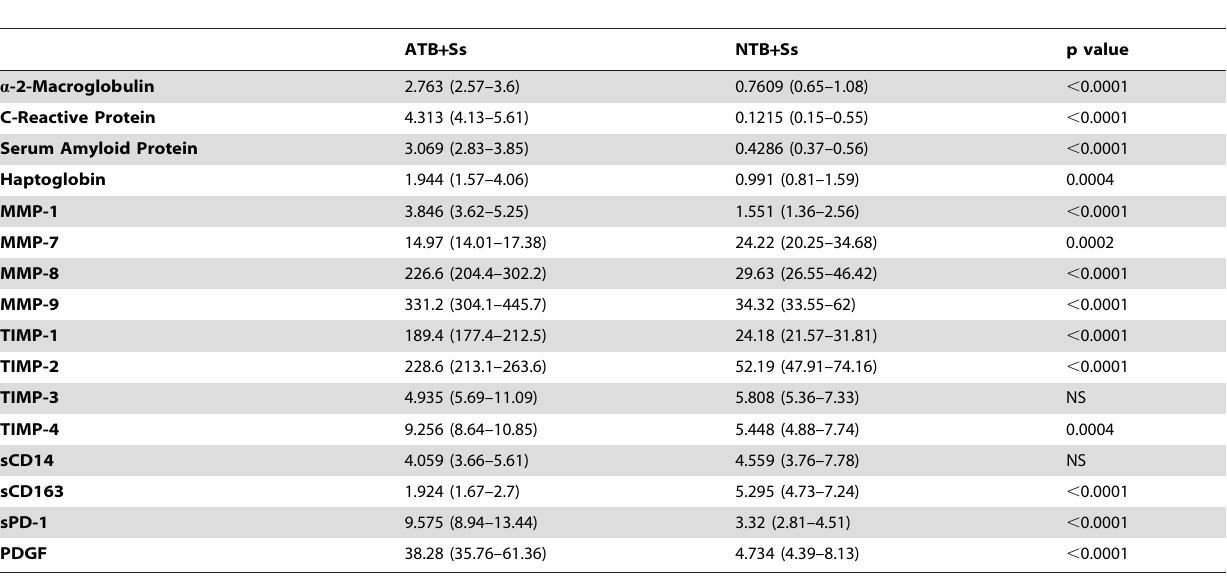
Table 3. Systemic levels of immune parameters in active TB and TB uninfected individuals with concomitant Strongyloides